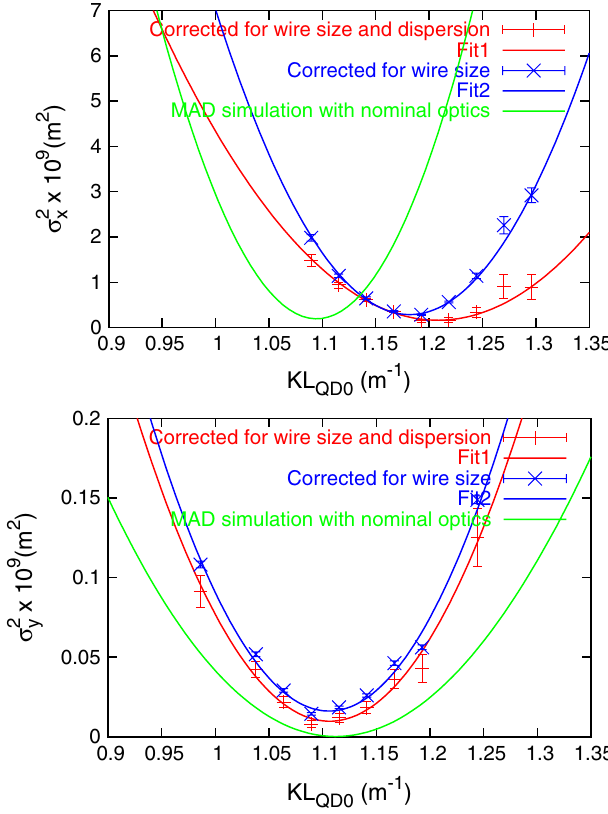
FIG. 7. Squares of horizontal and vertical beam sizes as a function of QD0 magnet strength on May 28 compared to the predictions from the optics simulation for the design large (cid:1) are the integrated QD0 magnet strengths, which optics. KL QD0 are computed from the power supply currents using relations based on the magnetic measurement data